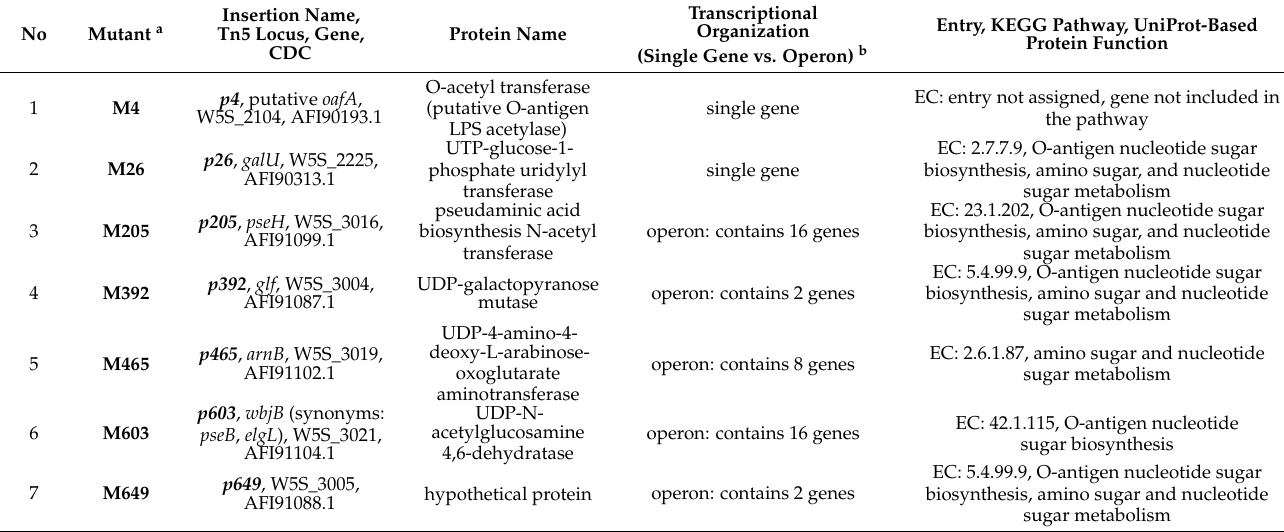
Table 1. Genetic loci of Pectobacterium parmentieri strain SCC 3193 Tn5 mutants expressing resistance against φ A38